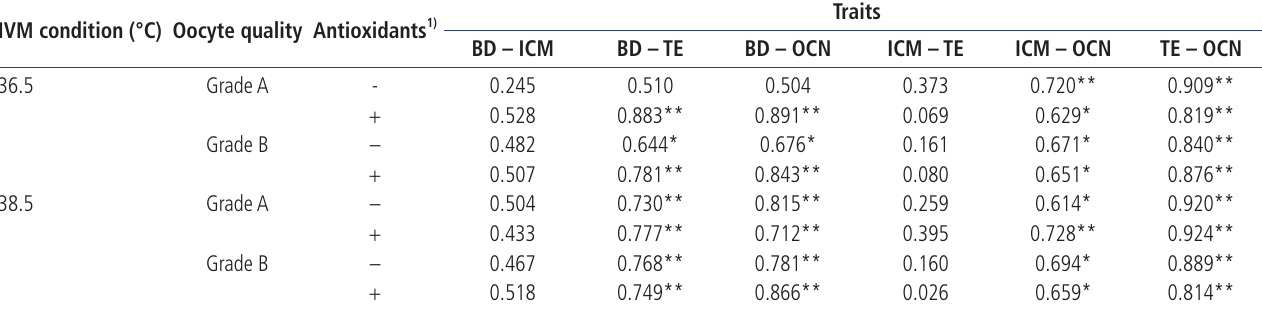
Table 5. Pearson correlation coefficients (95% confidence intervals) between diameter and cell numbers of various parts of blastocysts IVM condition (°C) Oocyte quality Antioxidants 1)